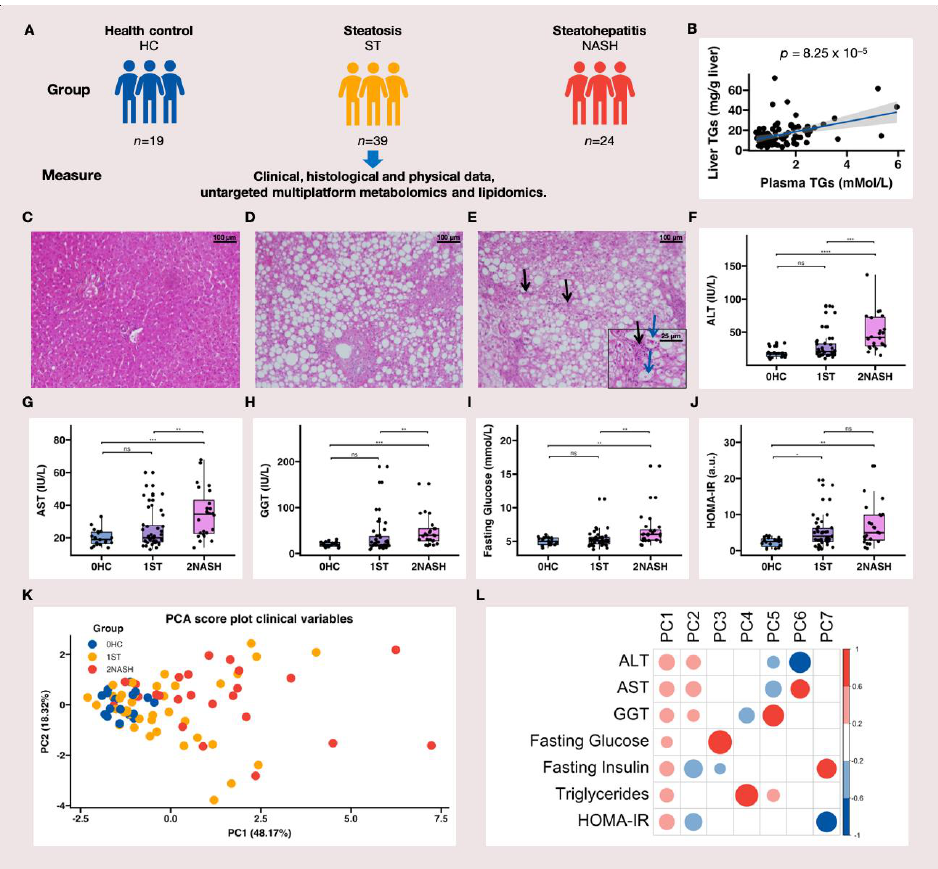
Figure 1 Figure 1. The associations between clinical characteristics and MAFLD: ( A ) a simplified diagram of the study design; ( B ) the correlation between plasma and liver TGs; ( C – E ) the results of the